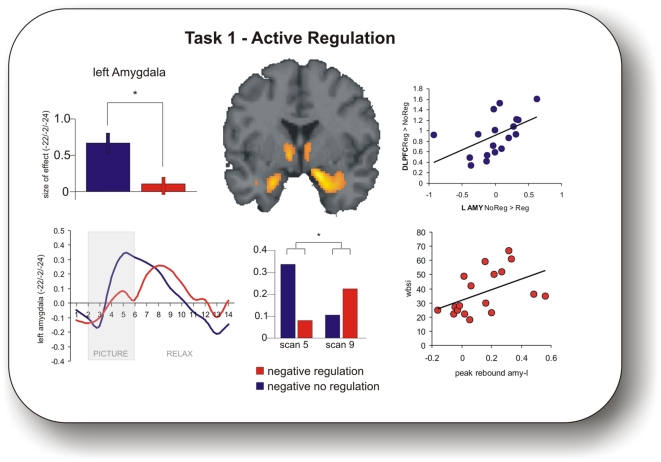
Task 1 (active regulation).Upper row left: Amygdala activation was significantly attenuated during regulation (p<0.05 FWE corrected for ROI). This regulation related decrease of amygdala activation was positively correlated with a regulation related increase in DLPFC activation (Upper row, right). Bottom row, left: Time course of left Amygdala, showing a significant postregulation rebound and a significant interaction of regulation and period (bar plot bottom row, middle). Note: all effects here shown for the left amygdala, are also significant for the right amygdala. Bottom row, right: Positive correlation between peak activation during relax period (rebound) in left amygdala and individual scores in the WBSI.